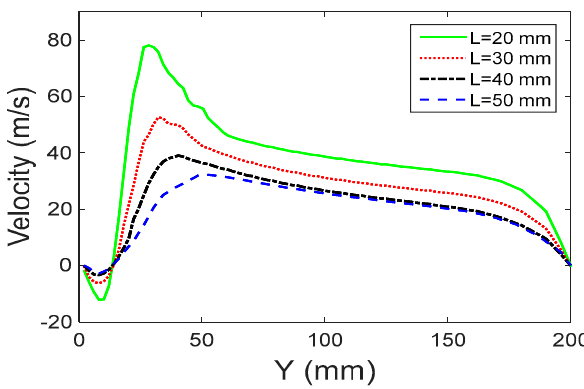
Figure 7. Velocity profiles along the central axis when θ = 10°.